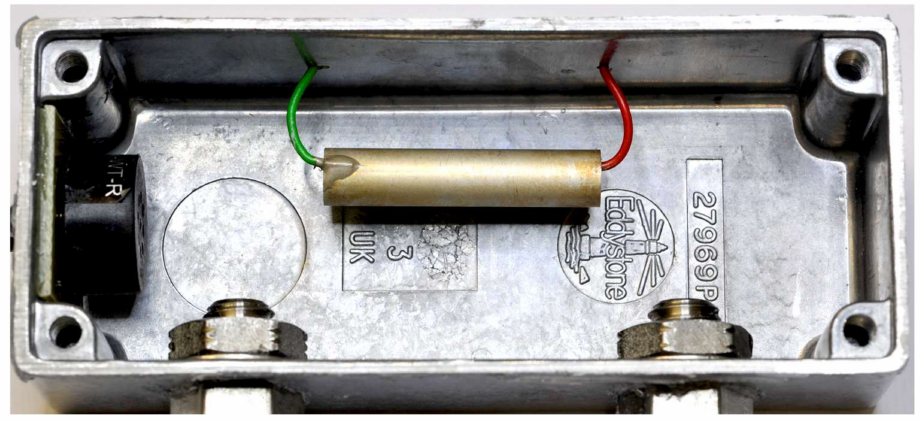
Figure 2. Photograph of the measuring cell with the suspended piezoelectric transducer in the center, the loudspeaker on the left and the gas in- and outlet at the